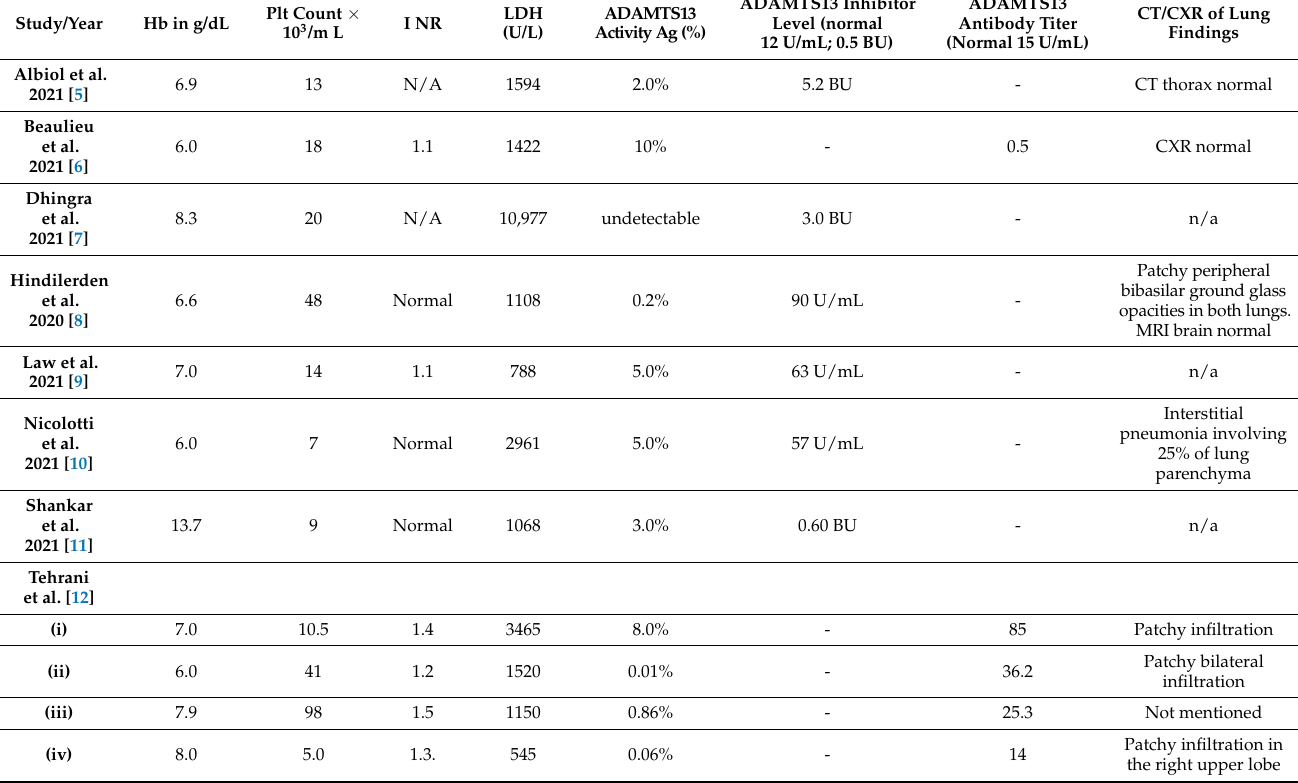
Table 2. Laboratory findings in patients with COVID-19-associated